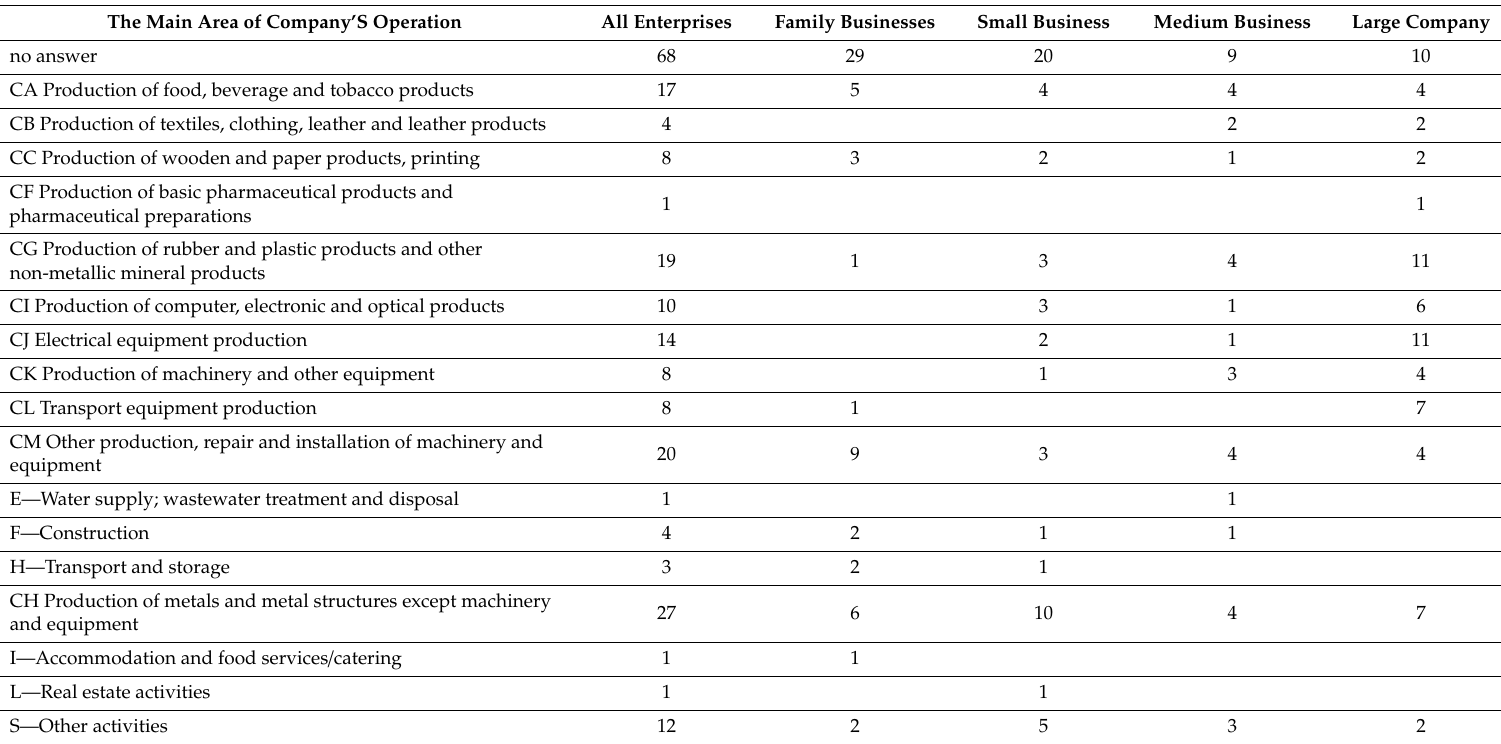
Table 1. The main area of the company’s